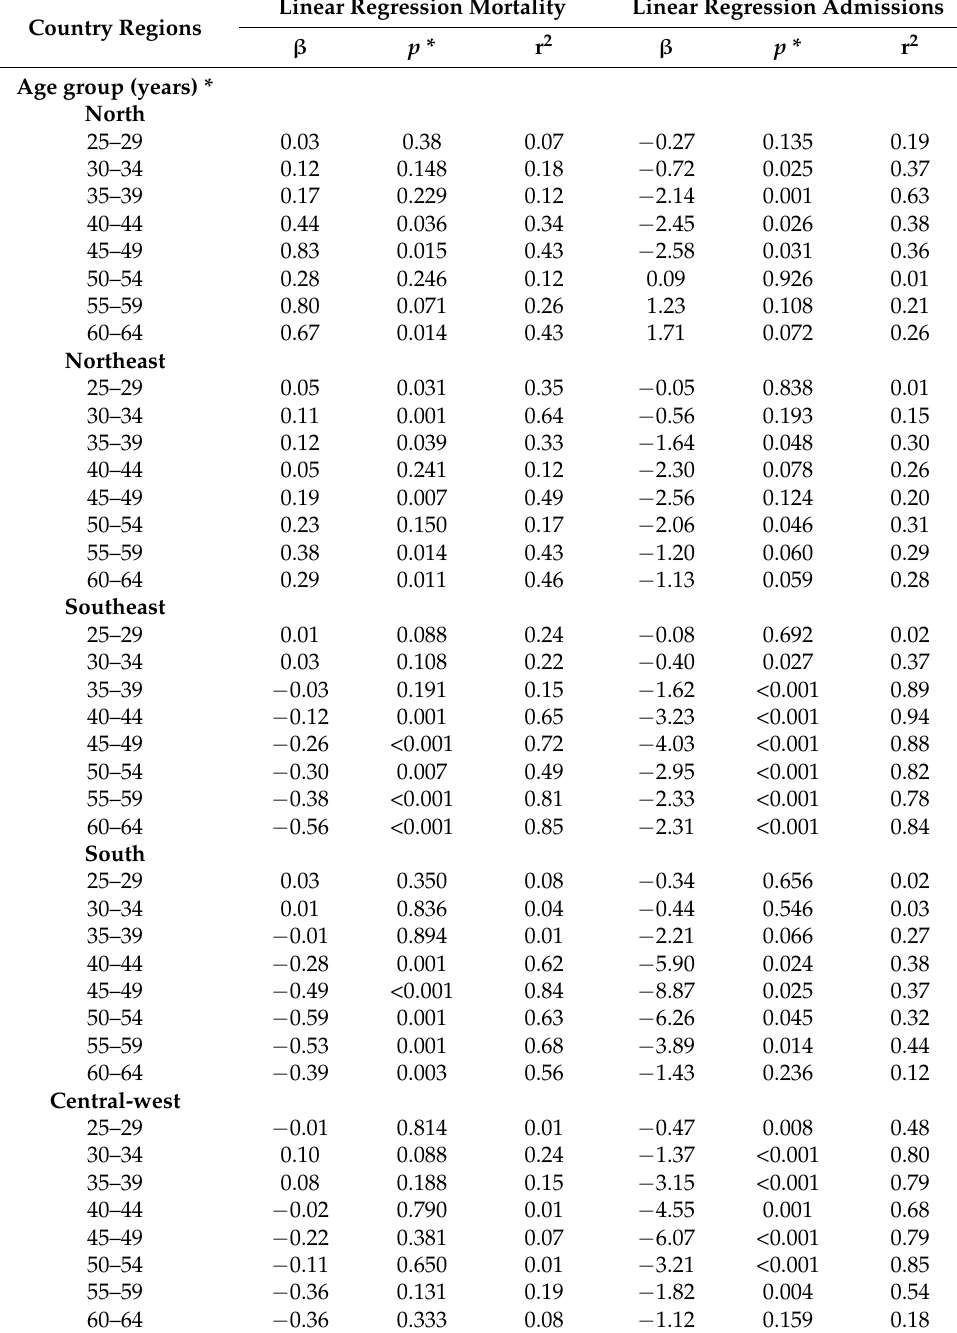
Table 2. Mortality linear regression * and incidence * of hospitalization (per 100,000 inhabitants) between 2000 and 2012, according to the regions of the